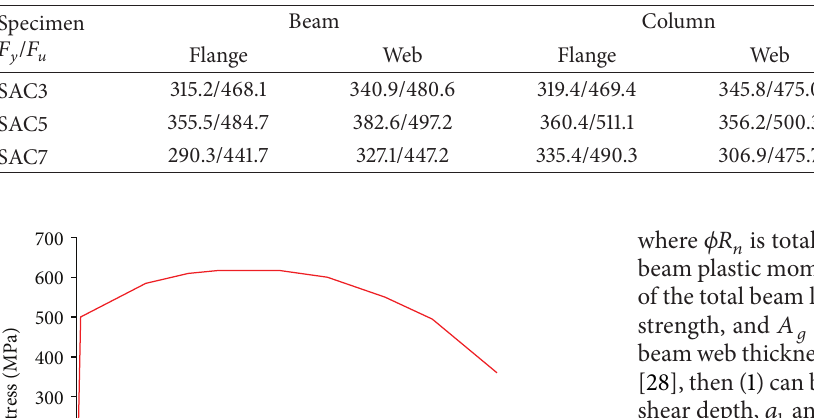
Table 2: Material properties of the SAC specimens (MPa).